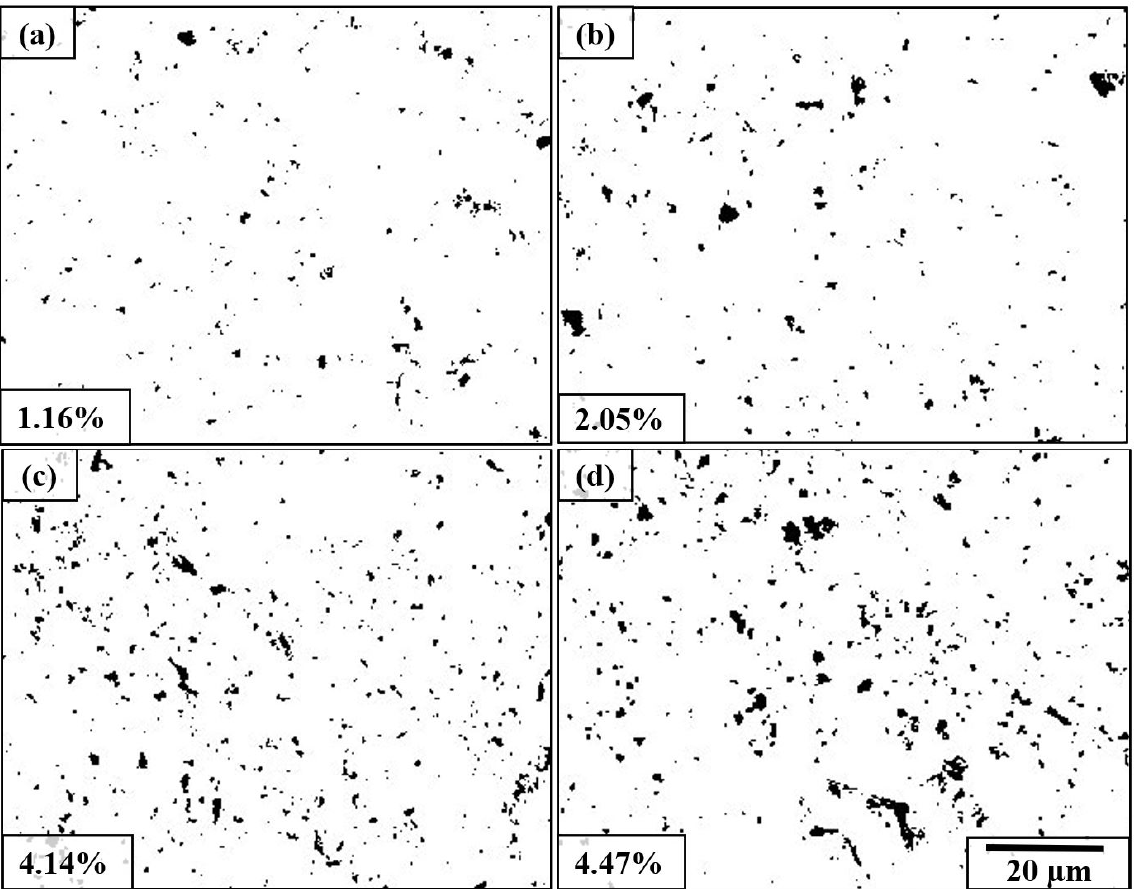
Figure 5. Areal coverage rate of embedded particles due to SP at ( a ) 0.1 MPa and 100% cover rate, ( b ) 0.1 MPa and 1000% cover rate, ( c ) 0.5 MPa and 100% cover rate, and ( d ) 0.5 MPa and 1000% cover rate. The black regions are the embedded shots, and the white background is the AA1050 alloy.